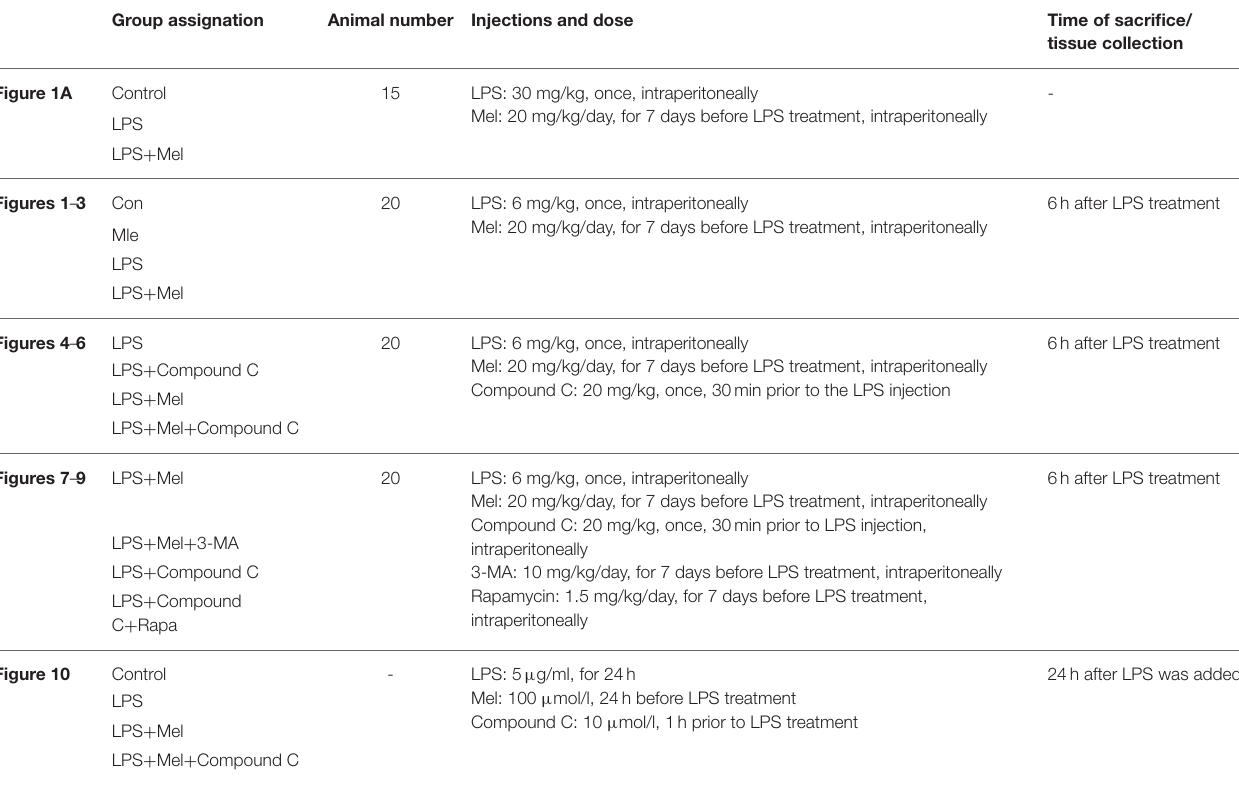
tissue collection